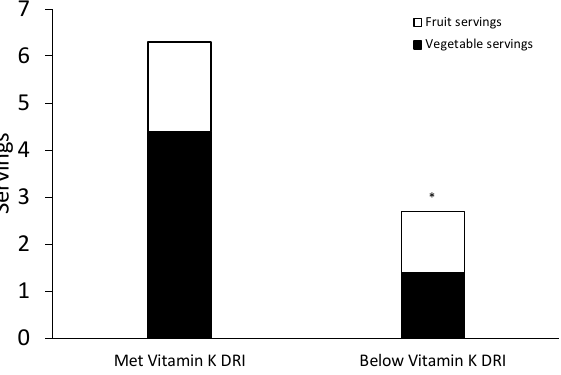
Figure 1. Total combined fruit and vegetable servings per day. * p = 0.05. DRI—Dietary Reference